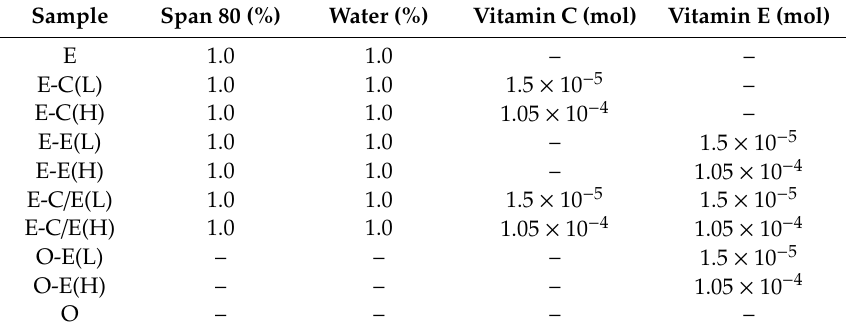
Composition of samples in the presence or absence of vitamins. Sample